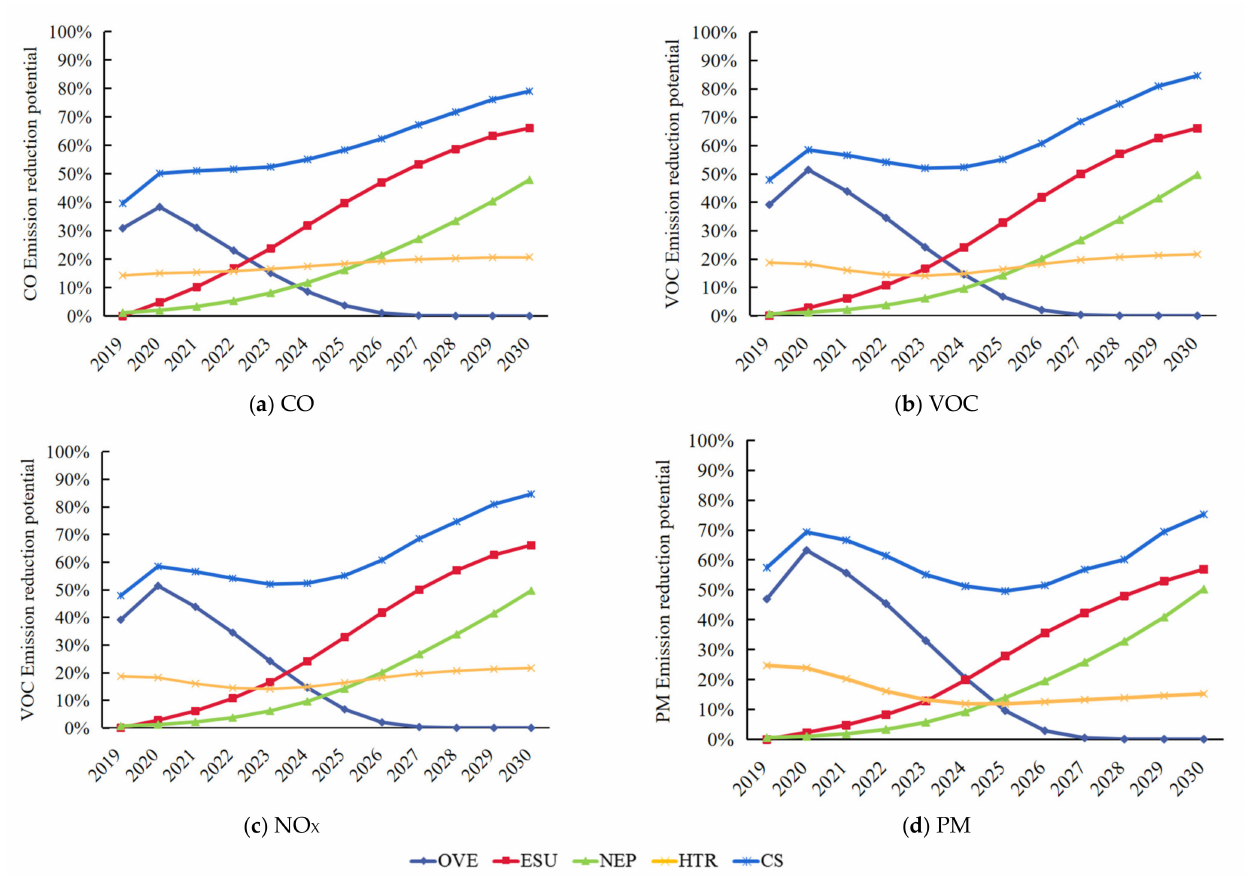
Figure 4. Prediction of pollutant emission reduction potential from diesel vehicles under different policy scenarios in